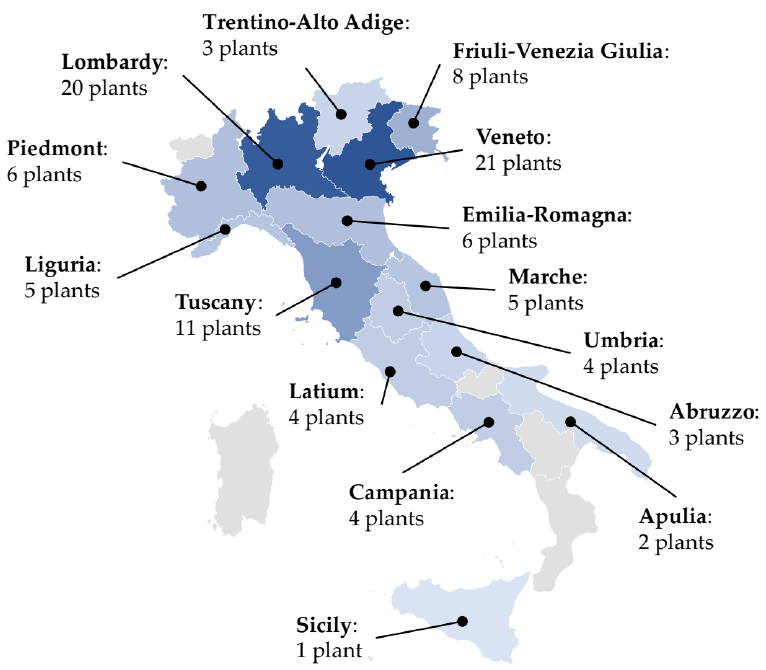
Figure 3. Geographical distribution of the 103 Italian glass plants constituting the referring